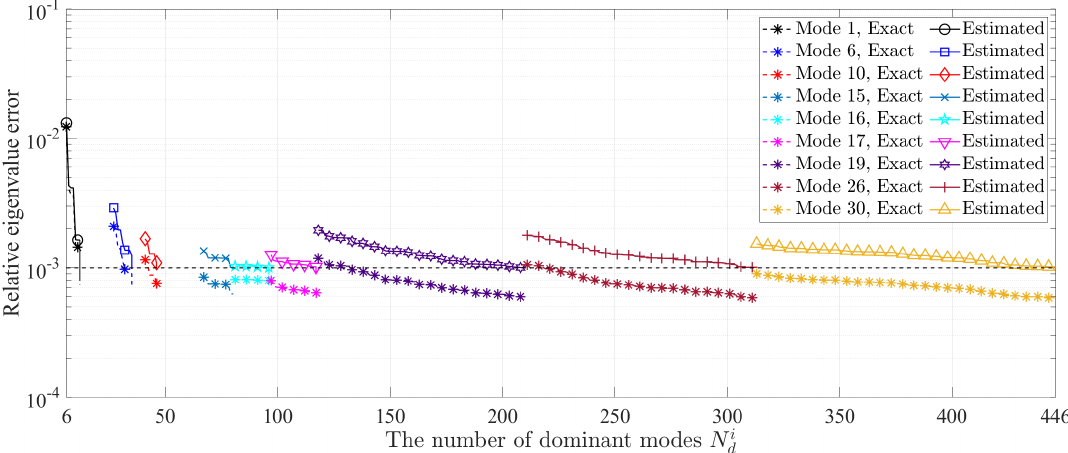
Figure 4. The changes of the relative eigenvalue error and its estimation with respect to the number of dominant modes for the specific modes. The error tolerance e i and the mode range N i m are 0.1% and 30,